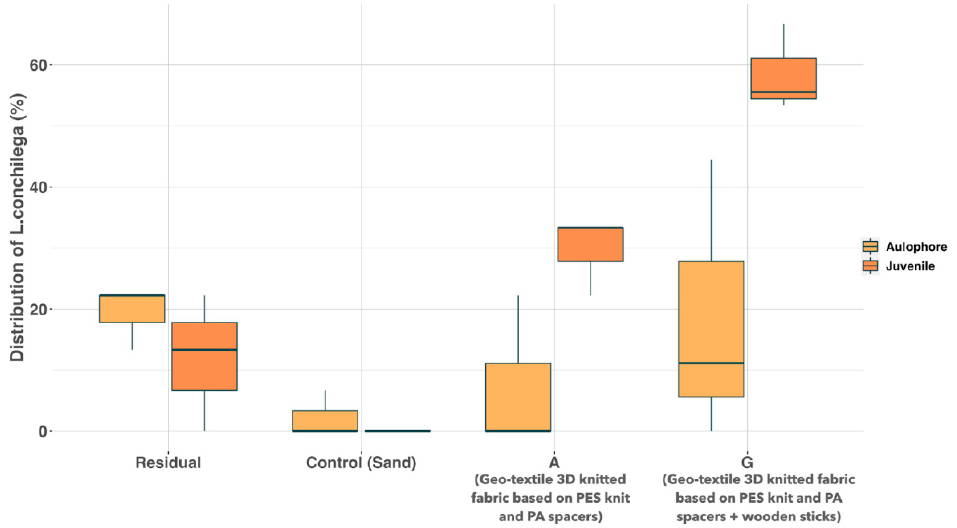
Figure 10. Box plot of distribution of L. conchilega juveniles (dark orange) and aulophores (light orange) in each fraction of the gutter and in the residual (water column and plastic part of the gutter). Three replicates were performed for each treatment. The distribution of individuals in each of the substrates is expressed as a percentage of the retrieved population.